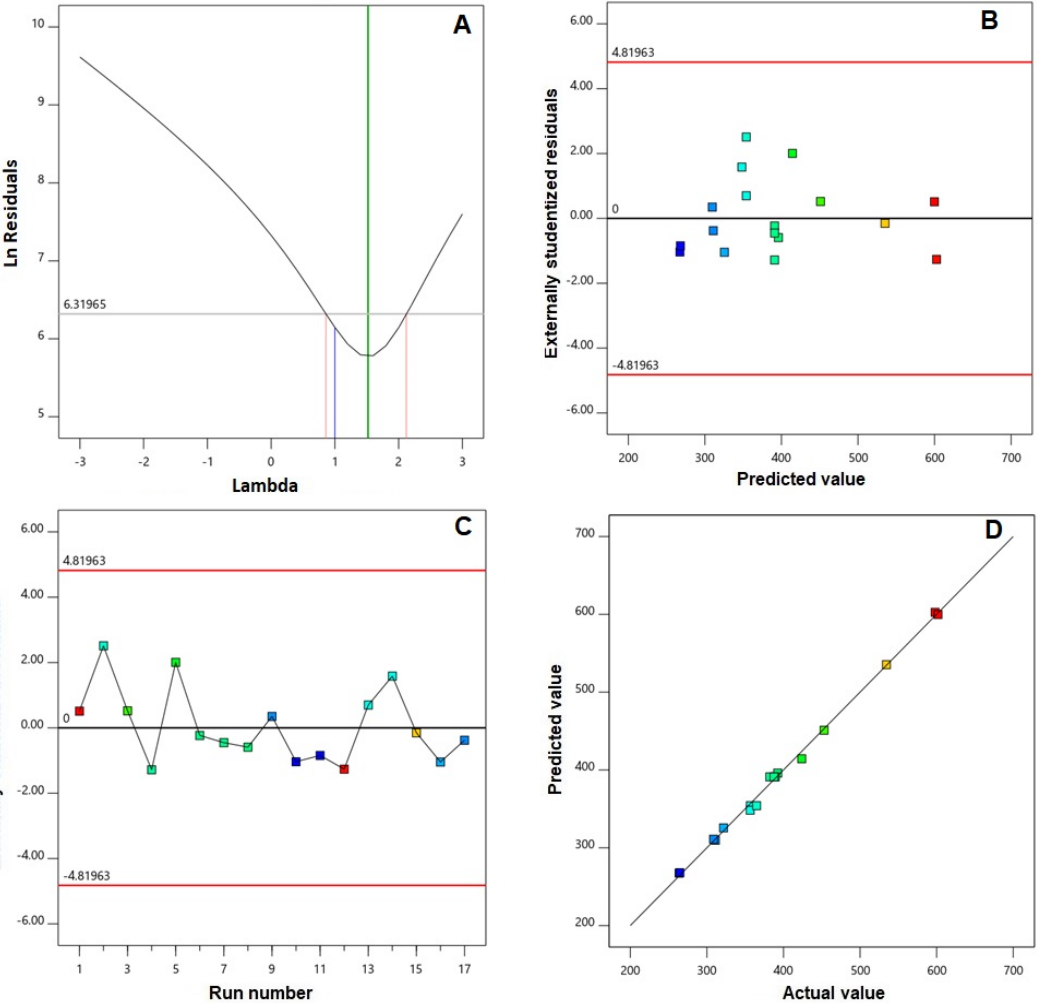
Figure 1. Diagnostic plots for vesicle size of EGA-EML-APA. ( A ) Box–Cox plot for power transforms ( B ) externally studentized residuals vs. predicted values plot ( C ) externally studentized residuals vs. run number plot and ( D ) predicted vs. actual values plot. Abbreviations: EGA, ellagic acid; EML, emulsomes; APA, apamin.